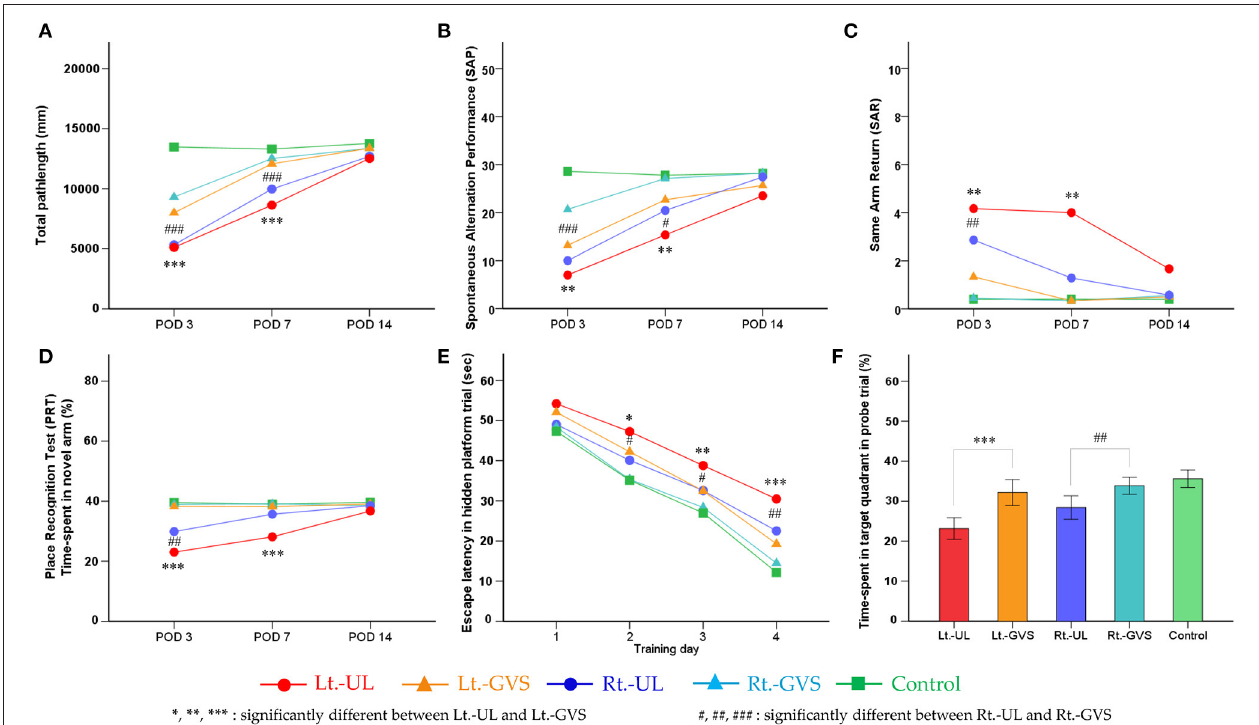
FIGURE 5 | Effects of galvanic vestibular stimulation (GVS) on the recovery post-UL. Bilateral bipolar GVS was applied as paradigms of cathode left–anode right (CLAR) for Lt.-GVS and cathode right–anode left (CRAL) for Rt.-GVS. Locomotion was reflected by the total path length on PODs 3 and 7 (A) and by SAP on PODs 3 and 7 (B) were markedly improved after GVS applications in both groups. The subgroup analysis between the Lt.- and Rt.-GVS groups revealed that the GVS intervention was significantly effective in the Rt.-UL mice compared with the Lt.-UL mice on POD 3 on total path length (A) and SAP (B) . Short-term spatial memory and attention reflected by SAP, SAR, and PRT during the Y maze were significantly improved after bipolar GVS intervention in both groups. The GVS protocol exhibited positive effects on the recovery of SAP on PODs 3 and 7. SAR showed significant improvement after GVS intervention in both side groups on POD 3 and the left side group only on POD 7. The GVS intervention was significantly more effective in the Rt.-UL mice than the Lt.-UL mice on POD 7 (C) . PRT was significantly improved after GVS on POD 3 and POD 7. Subgroup analysis revealed that the GVS intervention was more effective in the Rt.-UL mice than the Lt.-UL mice on POD 3 and POD 7 (D) . Long-term consolidative spatial memory reflected by the escape latency in MWM was improved after GVS in both side groups on hidden platform training days (TDs) 2, 3, and 4. There was, however, no noticeable difference between the Lt.-GVS and Rt.-GVS groups (E) . The probe trial on POD 14 showed substantial improvement after GVS intervention in both side groups with a significant difference between the Lt.-GVS and Rt.-GVS groups (F) . Values are indicated as mean. Statistical significances were calculated using the one-way ANOVA with post-hoc tests, except the Kruskal–Wallis test combined with Mann–Whitney U -test for SAR. The difference in the influence of GVS on CLAR and CRAL models was analyzed by independent t -test values comparing the delta values of Lt.-GVS and Lt.-UL to the respective delta values of Rt.-GVS and Rt.-UL. *Significant difference between Lt.-UL and Lt.-GVS; #significant difference between Rt.-UL and Rt.-GVS; *, # p < 0.05; **, ## p < 0.01; ***, ### p <